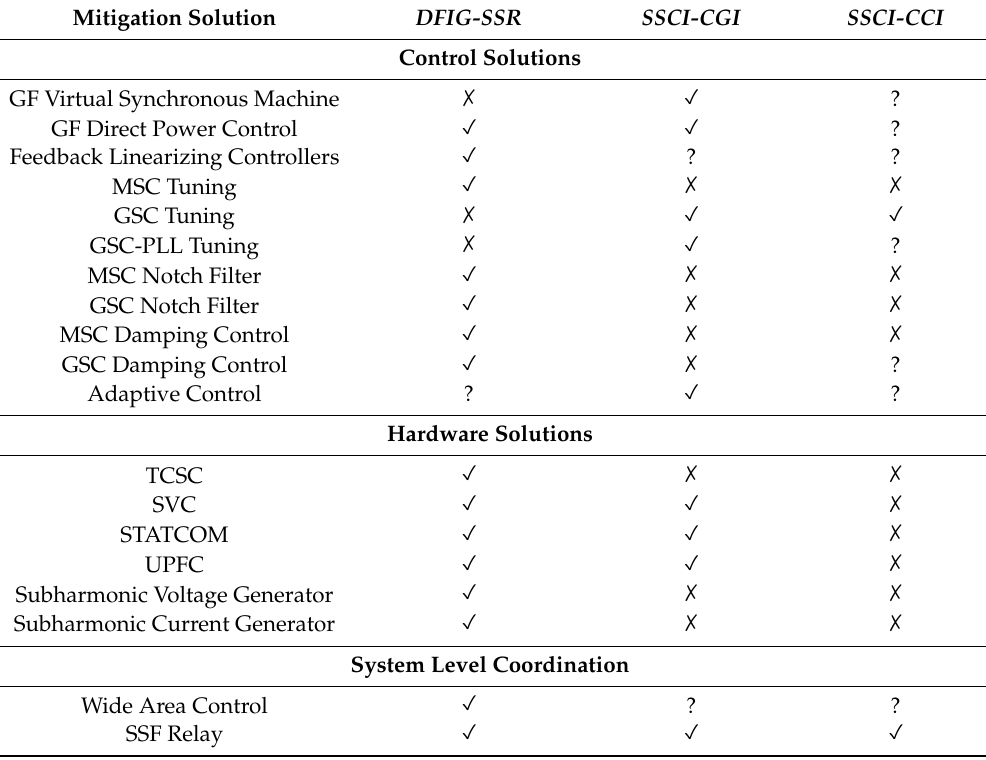
Table 2. Overview of mitigation solutions.